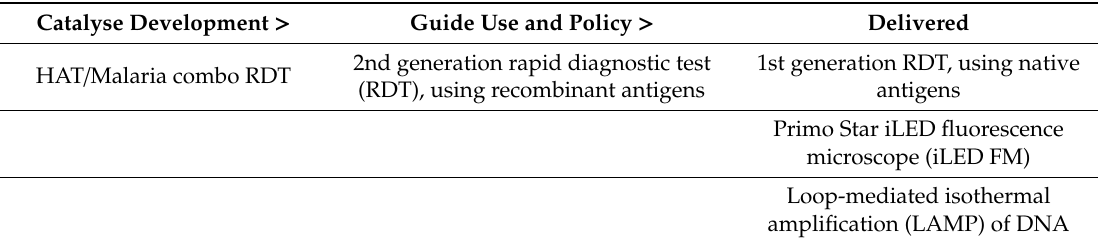
Table 2. FIND’s HAT